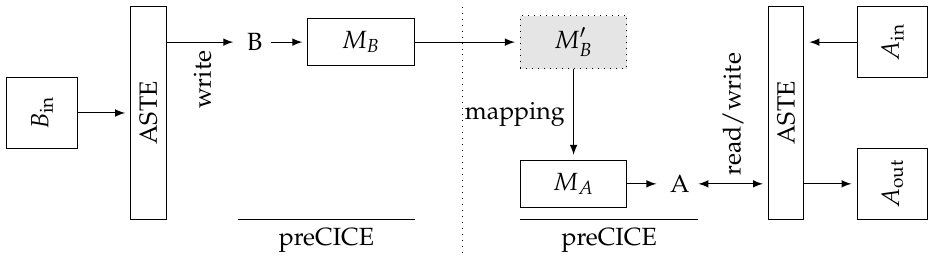
Figure 6. Test configuration using ASTE. Participant B on the left reads the mesh structure and physical data from a file B in . Participant A on the right reads the mesh structure from the file A in . B and A initialize communication, then data are transferred from M B to M (cid:48) nearest-projection mapping and finally written to a file A out